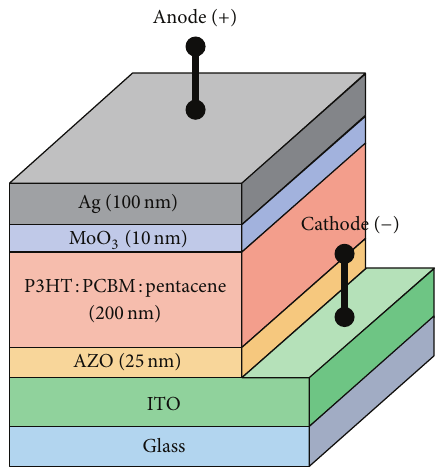
Figure 1: Schematic configuration of the inverted PSCs